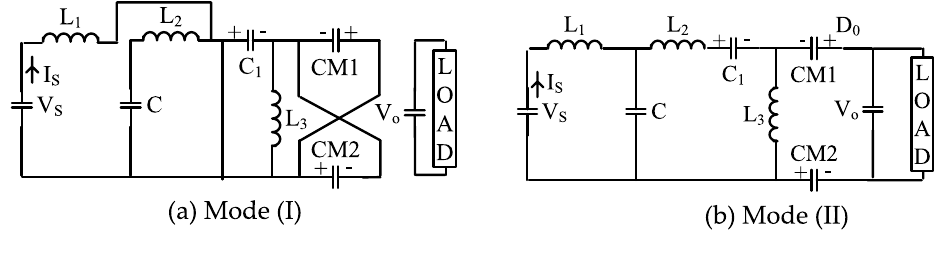
Figure 6. Proposed converter mode of